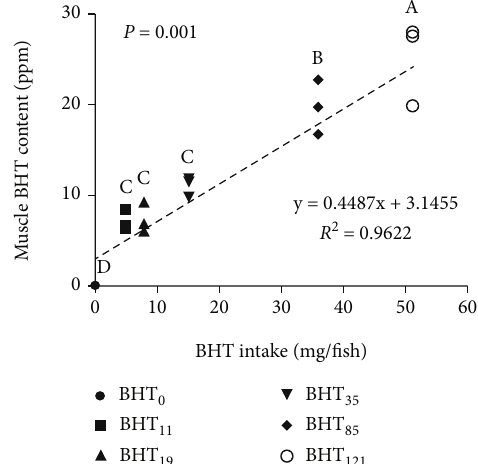
Figure 2: Muscle-speci fi c BHT accumulation in olive fl ounder ( Paralichthys olivaceus ) fed experimental diets over a 120-day growth trial. Values are means from triplicate groups of fi sh where the values in each row with di ff erent superscripts are signi fi cantly di ff erent ( P < 0 : 05